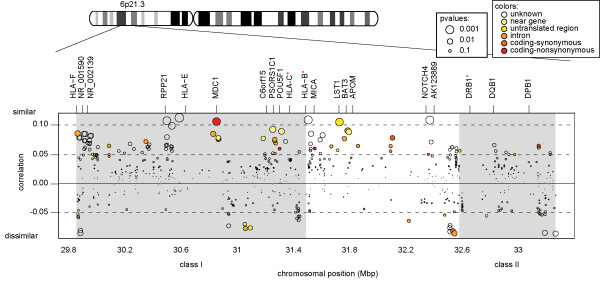
MHC correlation plot. The y-axis shows the correlation between couples at each SNP. Positive correlation means that the SNP shows identity between couples; negative correlation means that the SNP shows dissimilarity between couples. The size of the points is proportional to the SNP-wise significance. The color of the points indicates the function of the SNP (from UCSC). The MHC region is a mosaic of positive and negative correlations. Classes I and II are shaded grey. Proposed MS-related genes are highlighted with red stars. Positions and gene symbols are from UCSC (build 36).